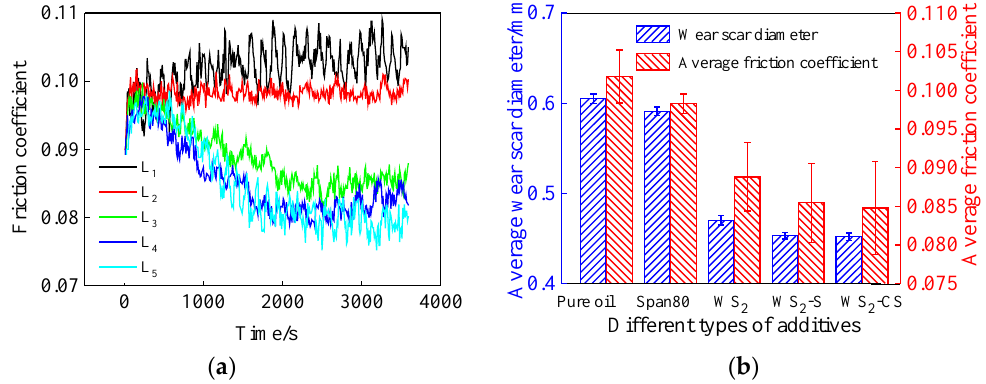
Figure 8. Curves of different additives: ( a ) varying friction coefficient; ( b ) average diameter of wear scar.